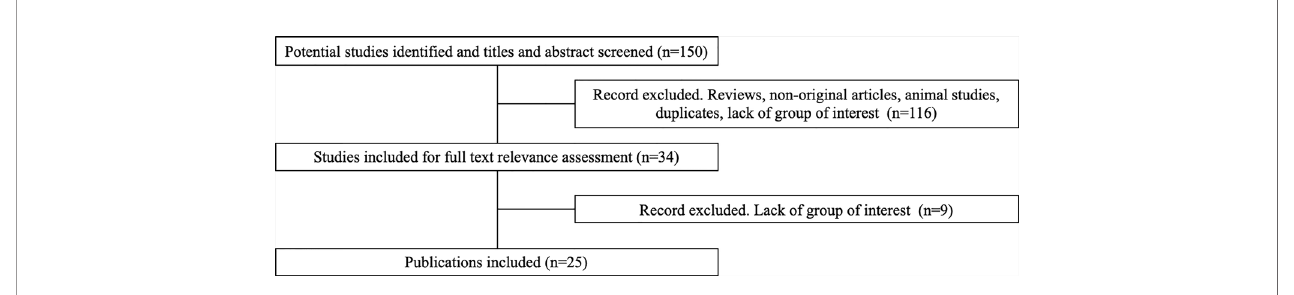
FIGURE 3 | Flow-chart of the literature eligibility